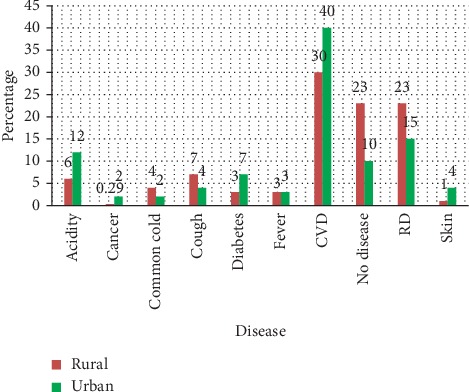
Prevalence of the disease among the population to visit PHCs.